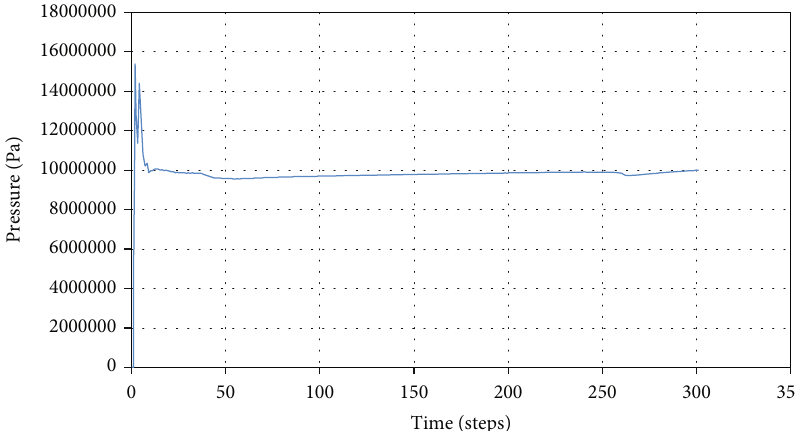
Figure 12: The fracture pressure changes with time.